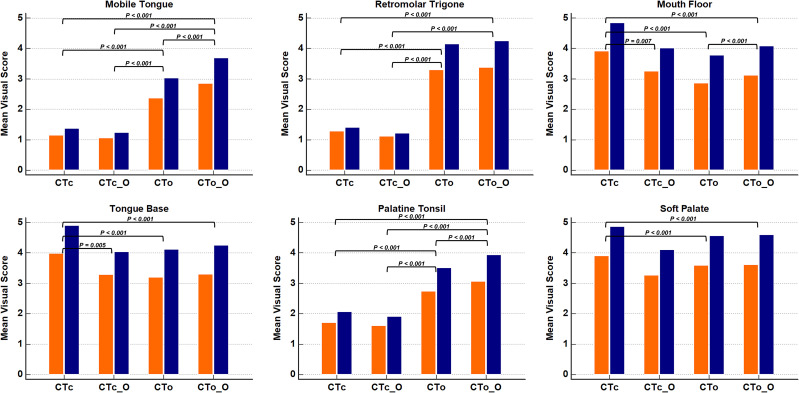
Box graphs of the mean values of the visual scores according to the anatomical structures and Computed Tomography (CT) protocols.The mean values of the 4-point visual scores assessing the degree of streak artifacts are shown in orange box, and the mean values of the 5-point visual scores assessing the overall subjective image quality are shown in the blue box. Statistically significant differences with P values less than 0.008 are presented in the figure. CTc = conventional CT; CTc_O = conventional CT with O-MAR processing; CTo = open mouth CT; CTo_O = open mouth CT with O-MAR processing; O-MAR = metal artifact reduction for orthopedic implants.